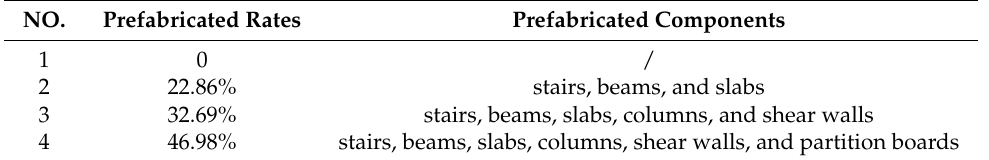
Table 4. The Matching of the Prefabricated rates and Components.